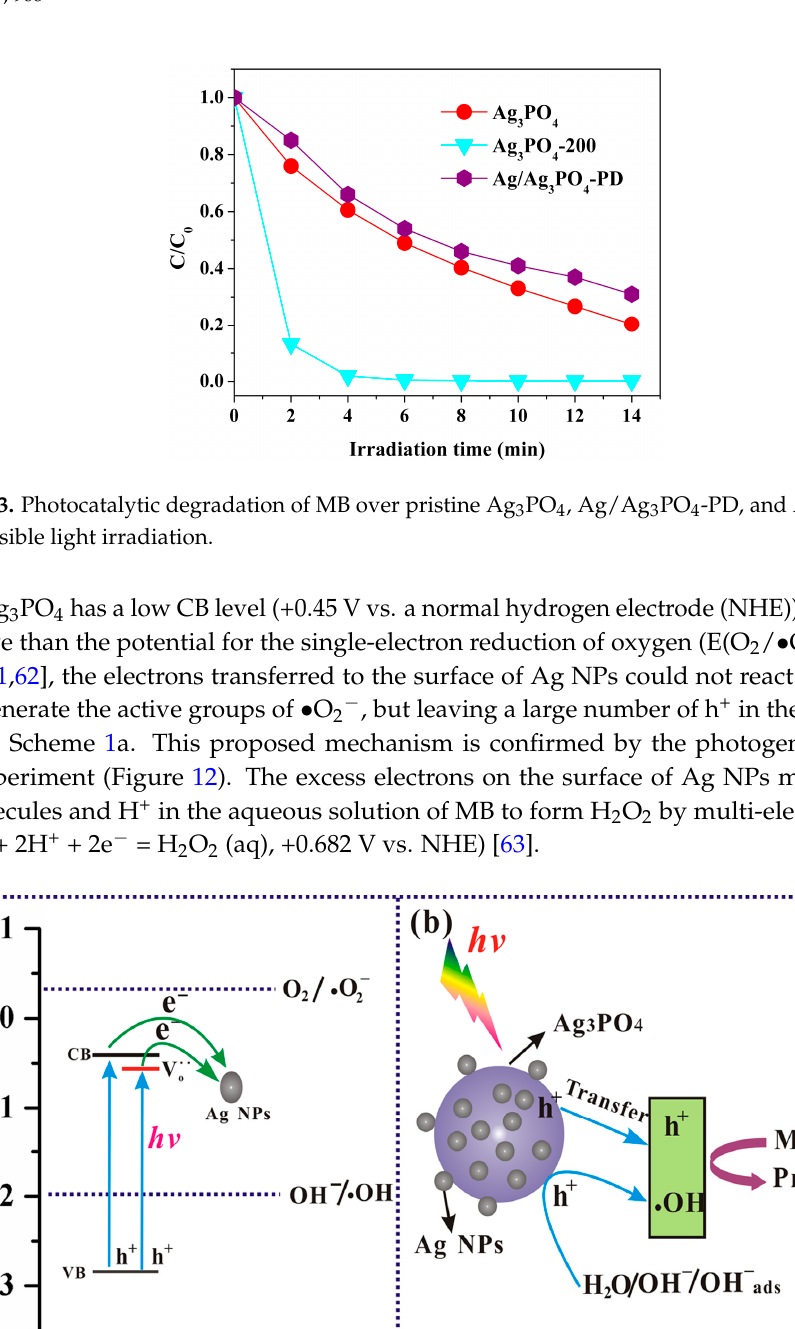
Figure 12. The photocatalytic activity of Ag 3 PO 4 -200 for the degradation of MB under visible light upon the addition of different scavengers.